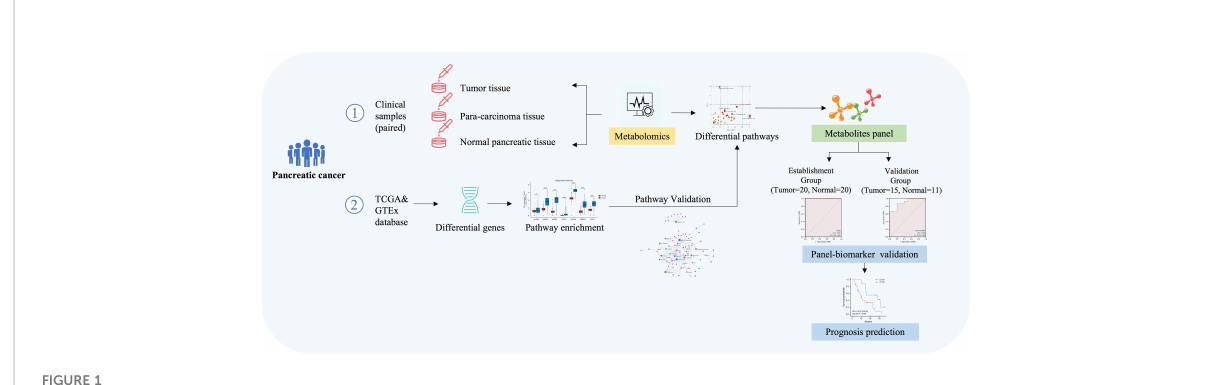
FIGURE 1 Work fl ow of the analysis